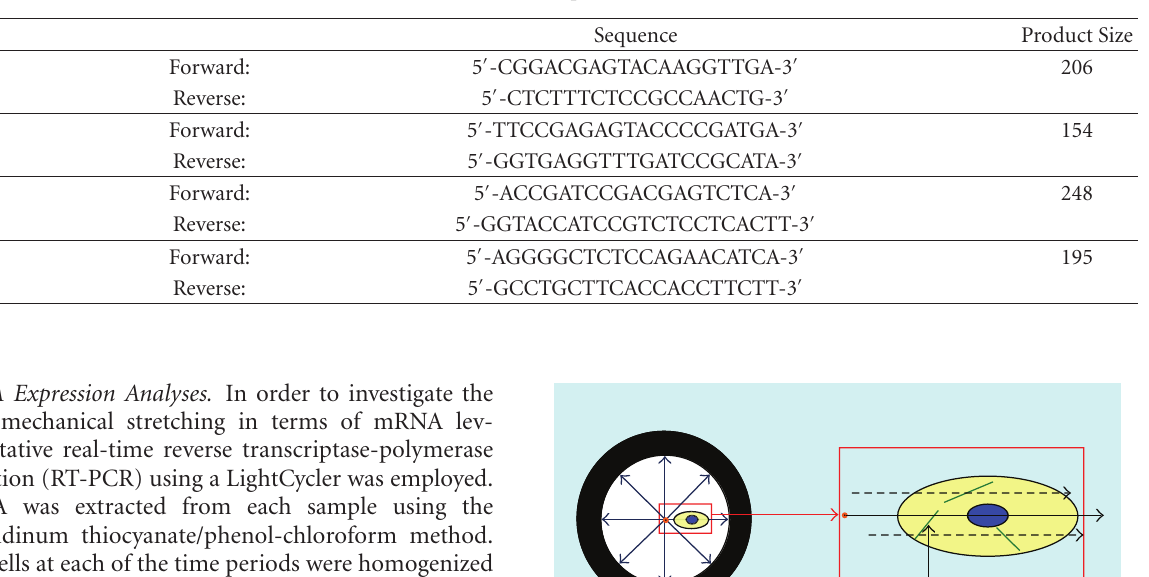
Table 1: Primer sequence.